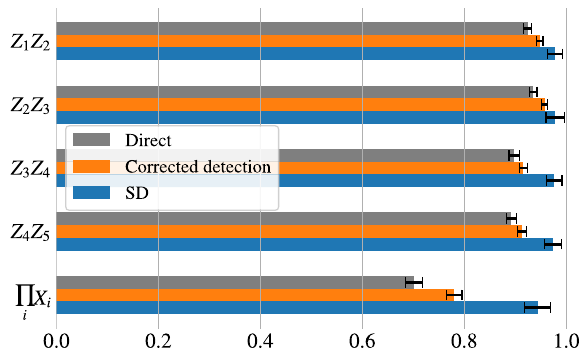
FIG. 10. Comparison of the experimental data (Direct), cor- rected data using detection calibration (Calibrated detection), and shadows distillation (SD) with N U = 2666 and N S = 50 mea- surements. The gap between the corrected detection and SD data (cid:7) in (cid:3) X i (cid:2) and its absence in the (cid:3) ZZ (cid:2) can be explained by the i existence of dephasing error in the